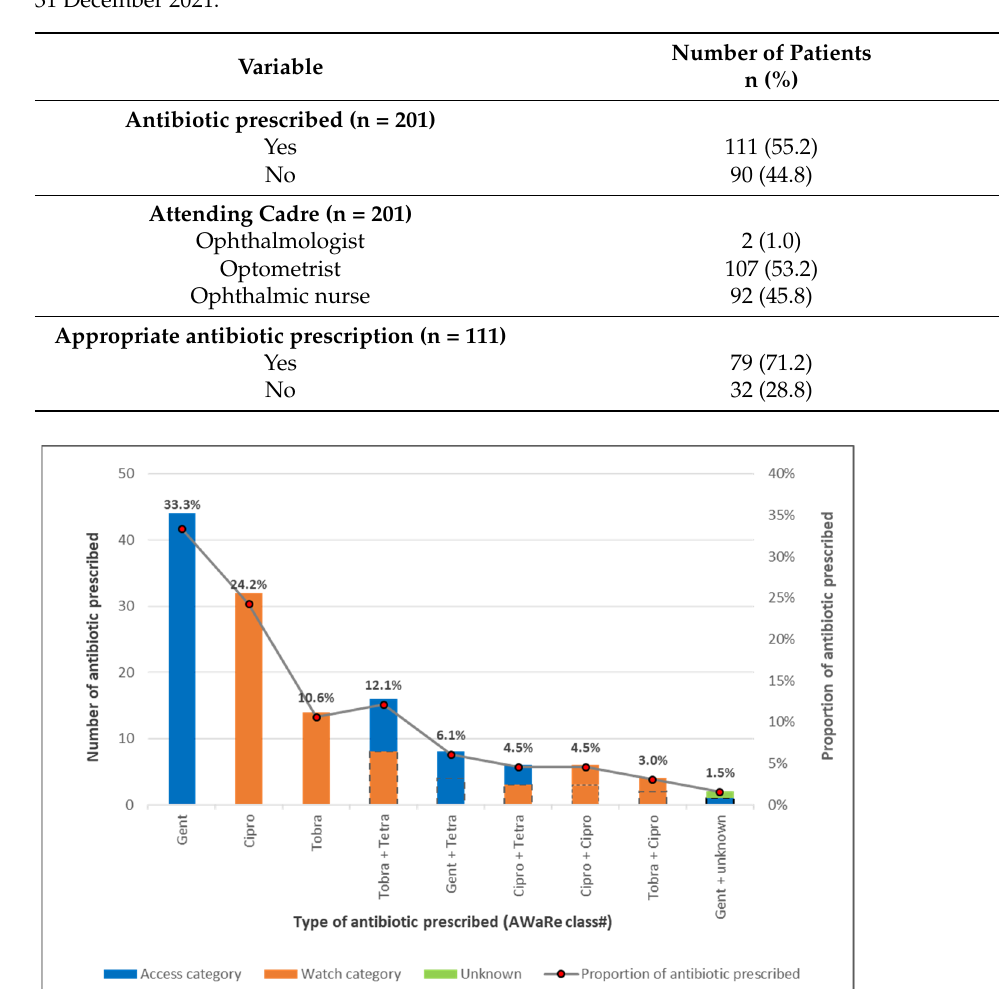
Table 2. Antibiotic prescription practices in a specialist eye hospital in Ghana from 1 January to 31 December 2021. Variable